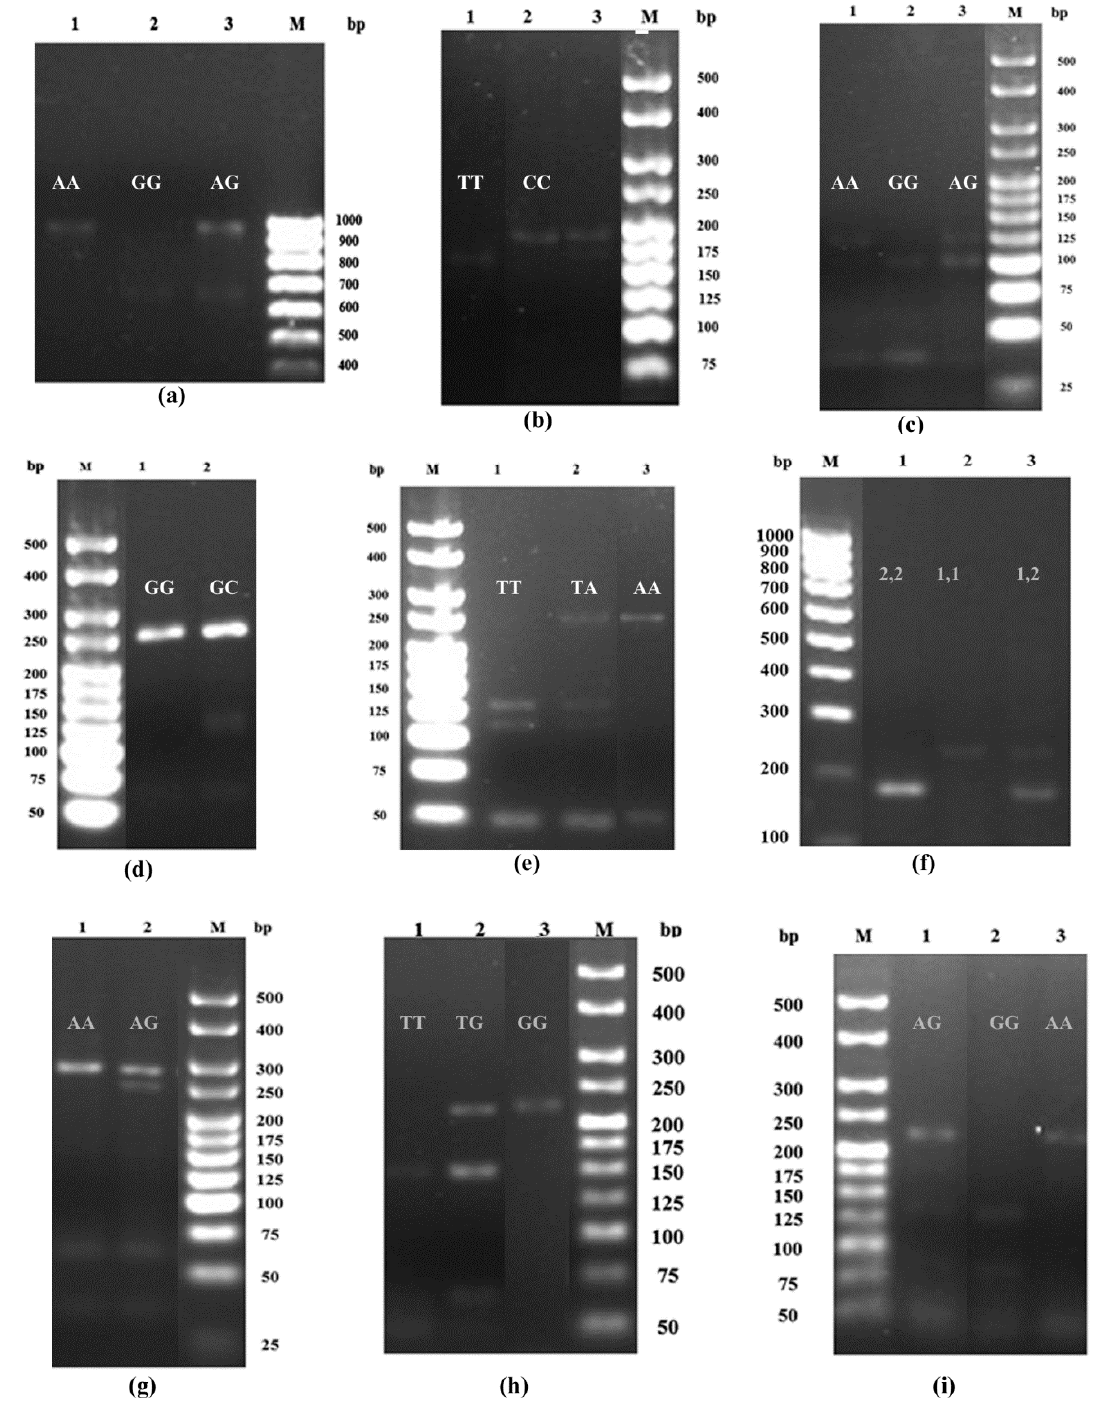
Figure 1. The PCR-RFLP products for ( a ) MCP1 polymorphism at position − 2518: AA (940 bp), GG (650 bp) and GA (940 and 650 bp) genotypes, ( b ) TGF β 1 polymorphism at position − 509: CC (178 bp), TT (159 bp) and TC (178 and 159 bp) genotypes, ( c ) TNF α polymorphism at position − 308: AA (117 bp), GA (117 and 97) and GG (97 bp) genotypes, ( d ) IL6 polymorphism at position − 174: GG (233 bp) and GC (233 and 122 bp) genotypes, ( e ) IL10 polymorphism at position − 3575: AA (228 bp), TA (228, 121 and 107 bp) and TT (121 and 107 bp) genotypes, ( f ) IL4 VNTR: 1,1 (253 bp), 2,2 (183 bp) and 1,2 (253 and 183 bp) genotypes, ( g ) TLR4 polymorphism at position 299: AA (249) and AG (249 and 223 bp) genotypes, ( h ) CD36 polymorphism at position − 188: GG (213 bp), TG (213, 148 bp) and TT (148) genotypes, and ( i ) ICAM1 polymorphism at position 469: AA (223 bp), GG (136), and AG (223, 136) genotypes.